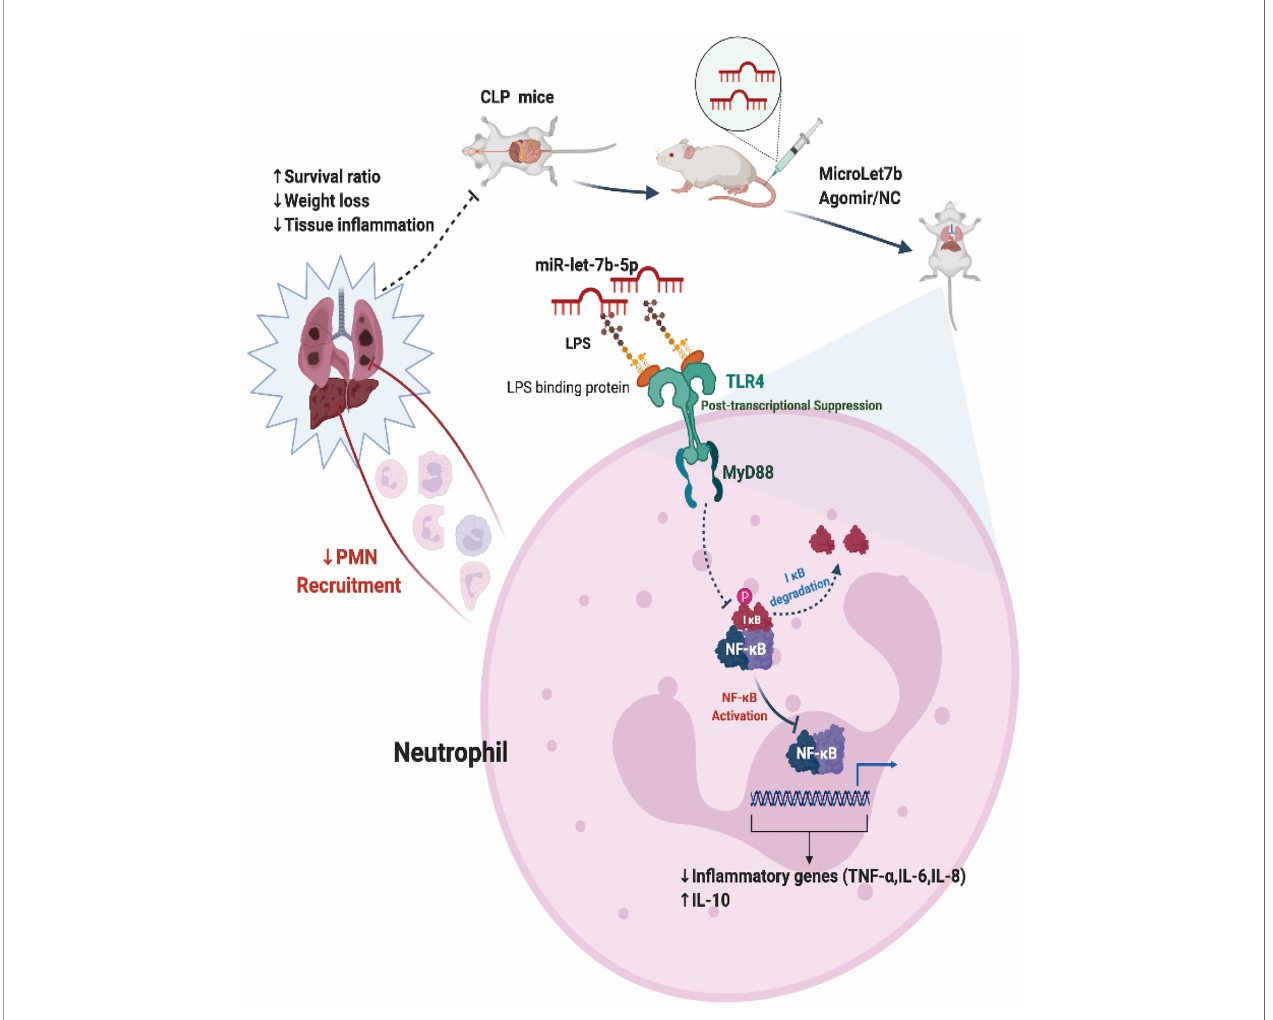
FIGURE 6 | Proposed model for miR-let-7b-mediated regulation of neutrophilic functions that target TLR4/NF- k B axis in vitro and in vivo